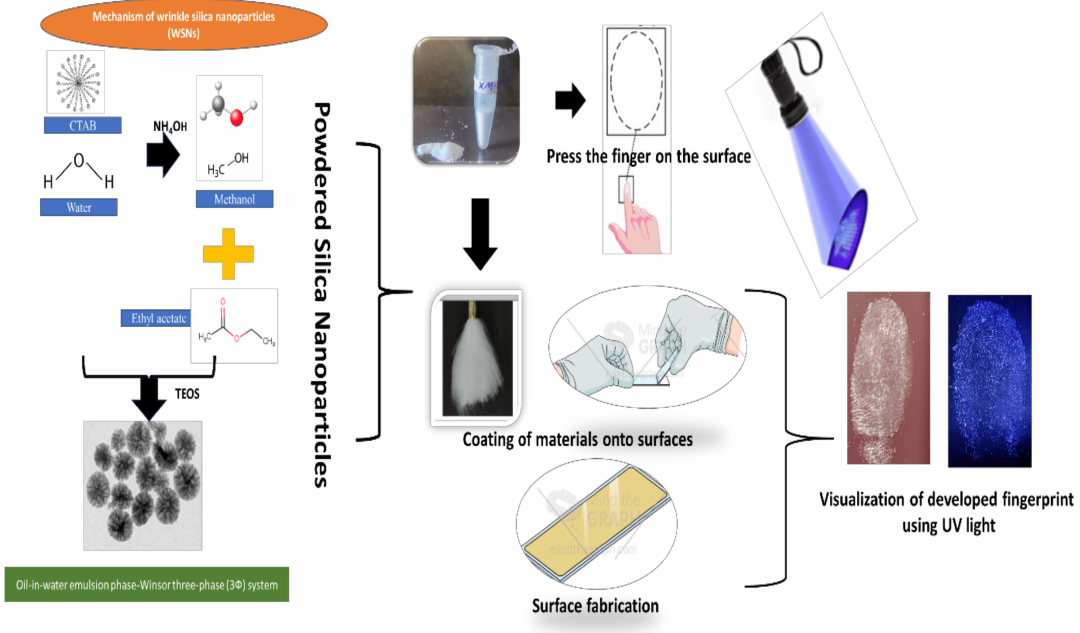
Figure 1. Method development for the application of MSNPs in detecting criminal